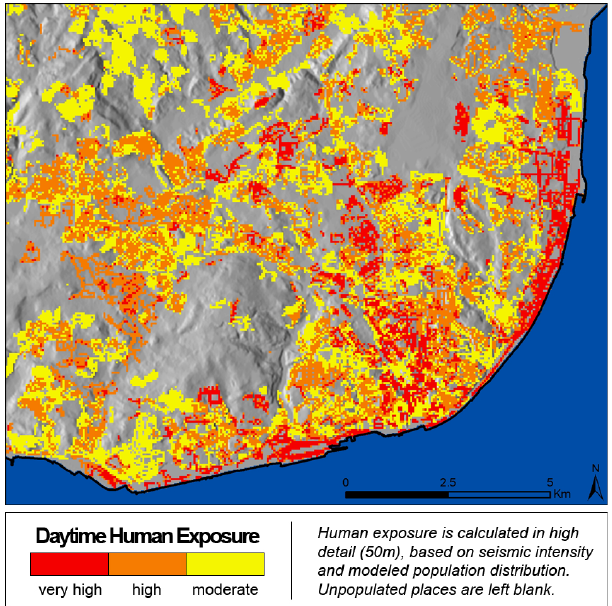
Fig. 6. Map of nighttime human exposure to seismic hazard, cen- tered in the city of Lisbon (terrain hillshade used as background).